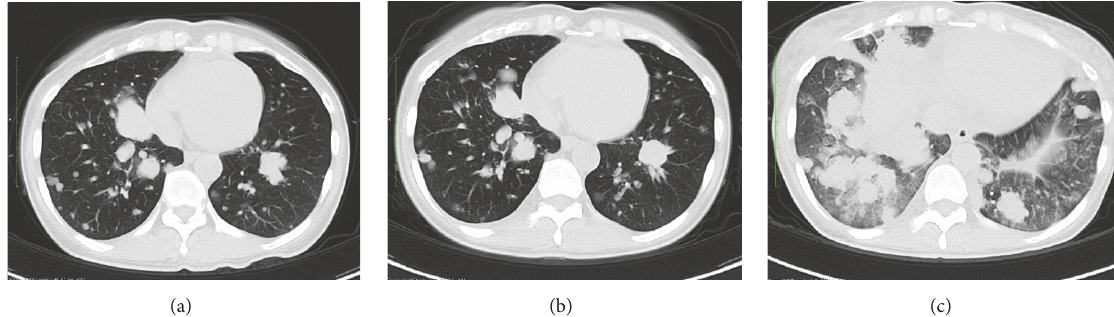
Figure 2: Transverse section of lung in computed tomography. (a) Start of pazopanib therapy. (b) End of pazopanib therapy. (c) After two weeks’ cessation of pazopanib